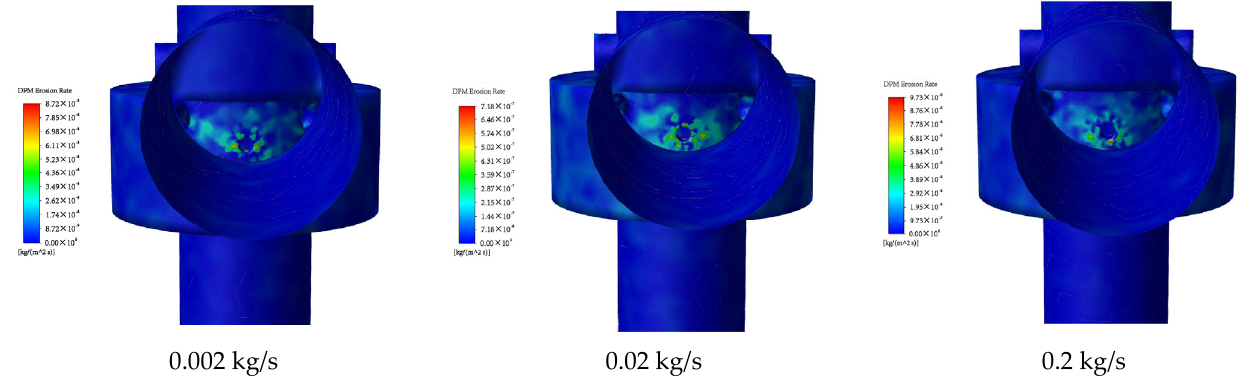
Figure 8. Erosion at different amounts of sand injection.